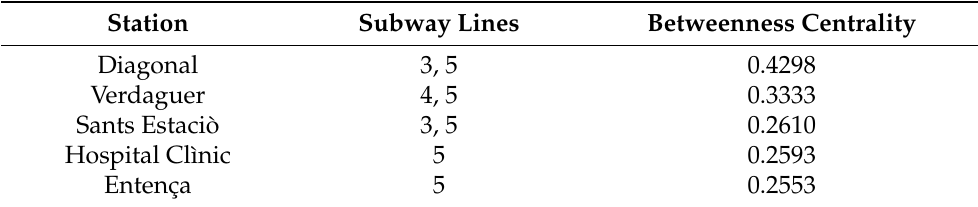
Table 3. The five stations with the highest betweenness centrality.